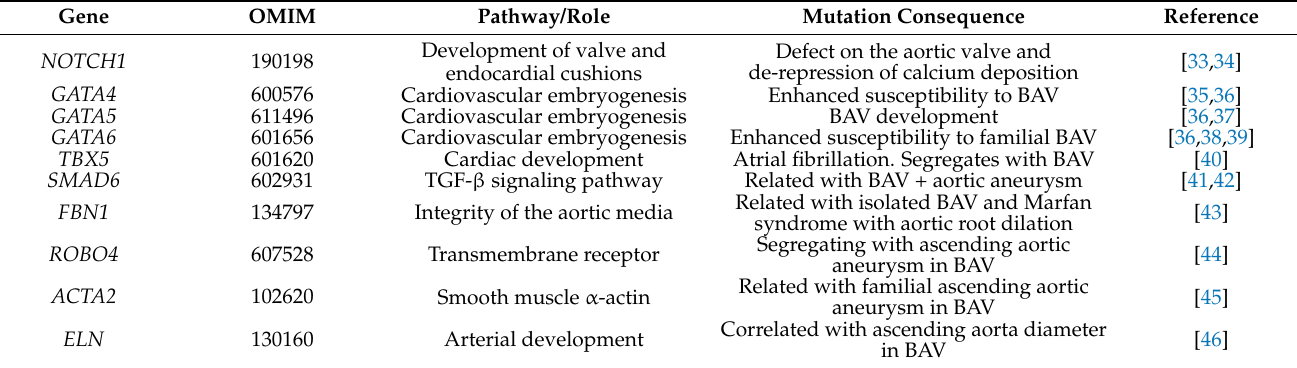
Table 1. Main genes associated with bicuspid aortopathy.